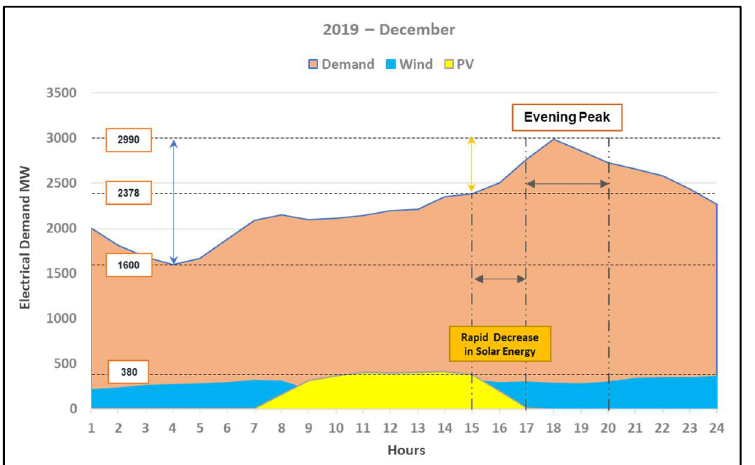
Figure 1. Jordan’s power demand and renewable energy generation for a day in winter at the end of 2019.